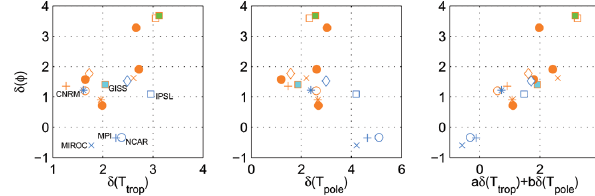
Fig. 6. Relationships between the anomaly of the jet stream max- imum position δφ and (a) the anomaly in tropical temperatures δT trop , (b) the anomaly in high-latitude lower troposphere temper- ature δT pole and (c) ( a × δT trop + b × δT pole ). See text (Sect. 4) for the definition of these quantities. The blue symbols accompanied by model names are the PI–LGM results. The corresponding red sym- bols are the RCP–PI results. Results from additional models listed in Sect. 2 are shown by filled red circles, except the IPSL models that are shown with filled blue (CM5B-LR) and green (CM5A-MR) squares.